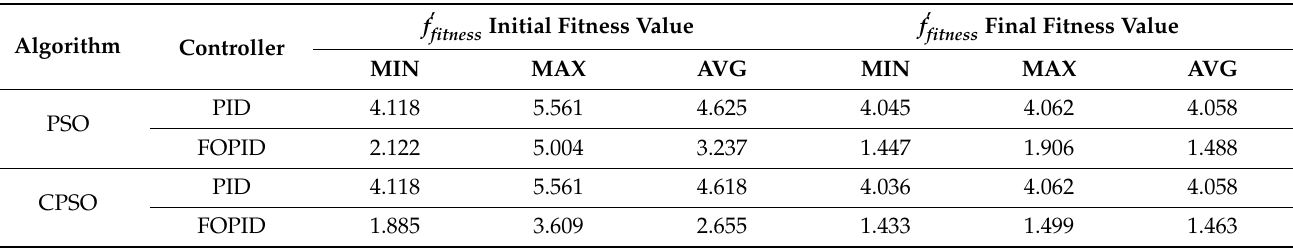
Table 3. Comparison of the parameters’ optimization results of two controllers by using PSO and CPSO.